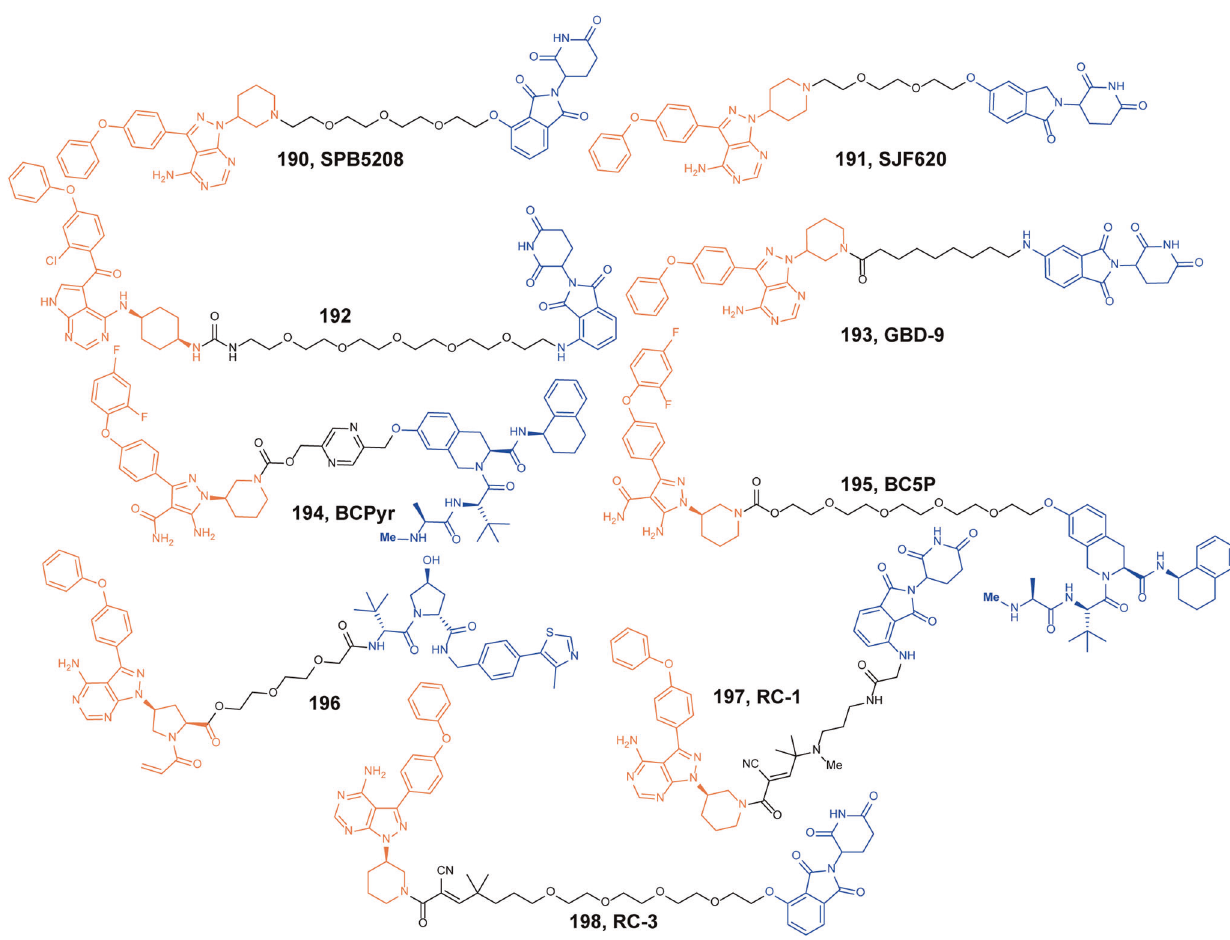
Fig. 53 The representative PROTACs targeting BTK